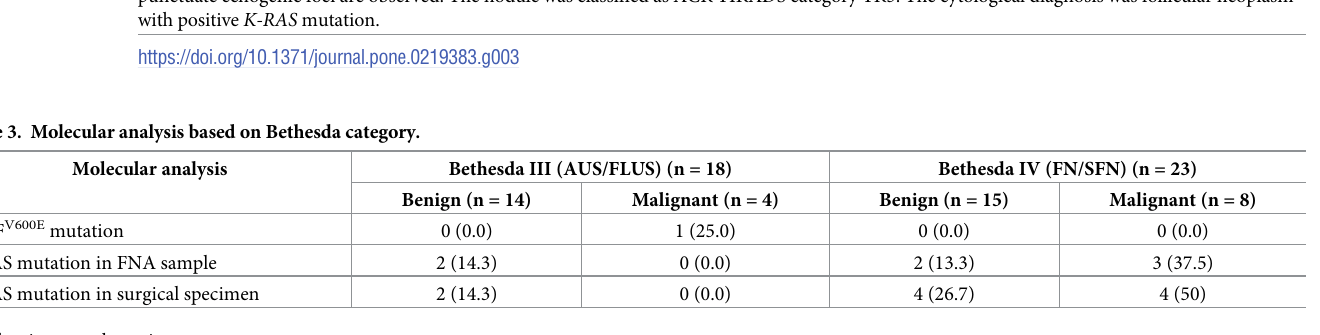
Fig 3. Ultrasound images in a patient with FTC (widely invasive) in the right lobe. A, B. Longitudinal (A) and transverse (B) US show a hypoechoic solid thyroid nodule (size: 43 mm × 24 mm × 29 mm) with wider-than-tall shape and extra-thyroidal extension. Macrocalcification and punctuate echogenic foci are observed. The nodule was classified as ACR TIRADS category TR5. The cytological diagnosis was follicular neoplasm with positive K-RAS mutation.